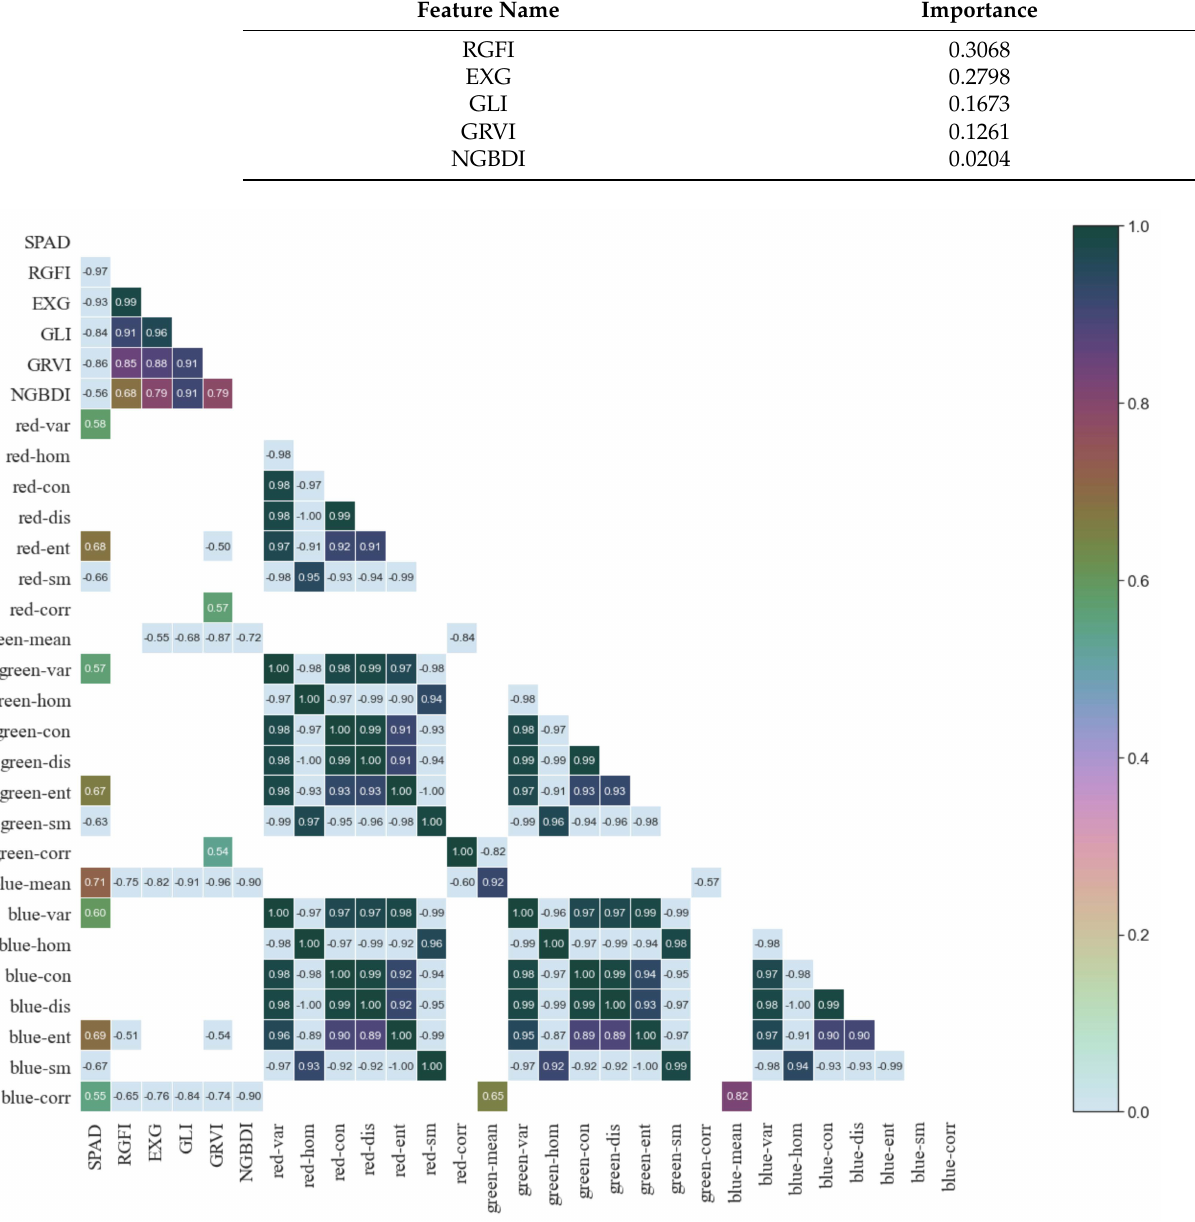
Figure 4. Feature screening results of the Pearson correlation coefficient